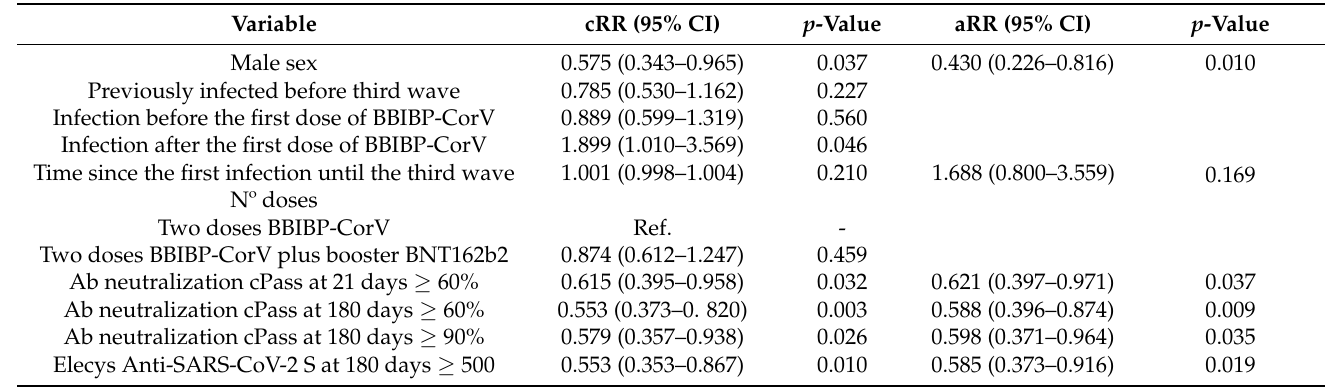
Table 2. Poisson regression analysis to evaluate predictors of COVID-19 vaccine breakthrough